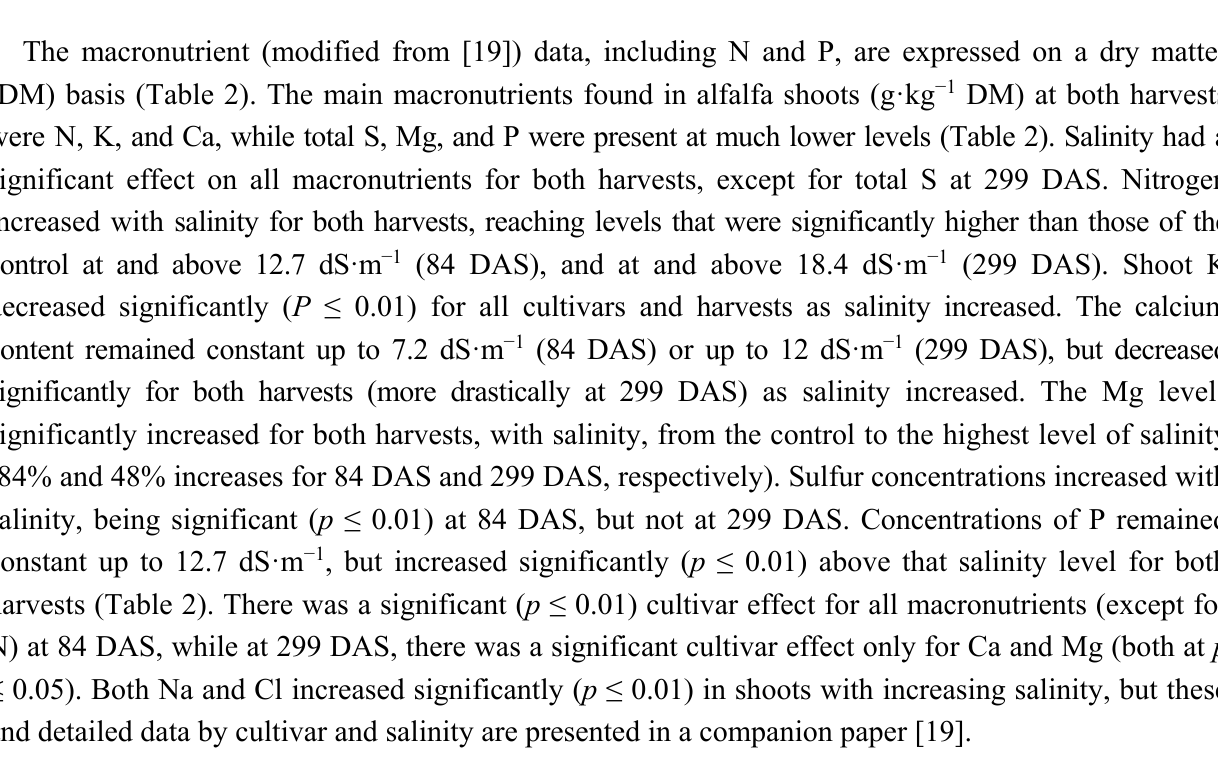
Table 2. Average macronutrients (±SE) in alfalfa shoot dry matter (DM) according to salinity levels. EC, electrical conductivity of irrigation water in deciSiemens per meter. ND, not determined (insufficient biomass). Modified from